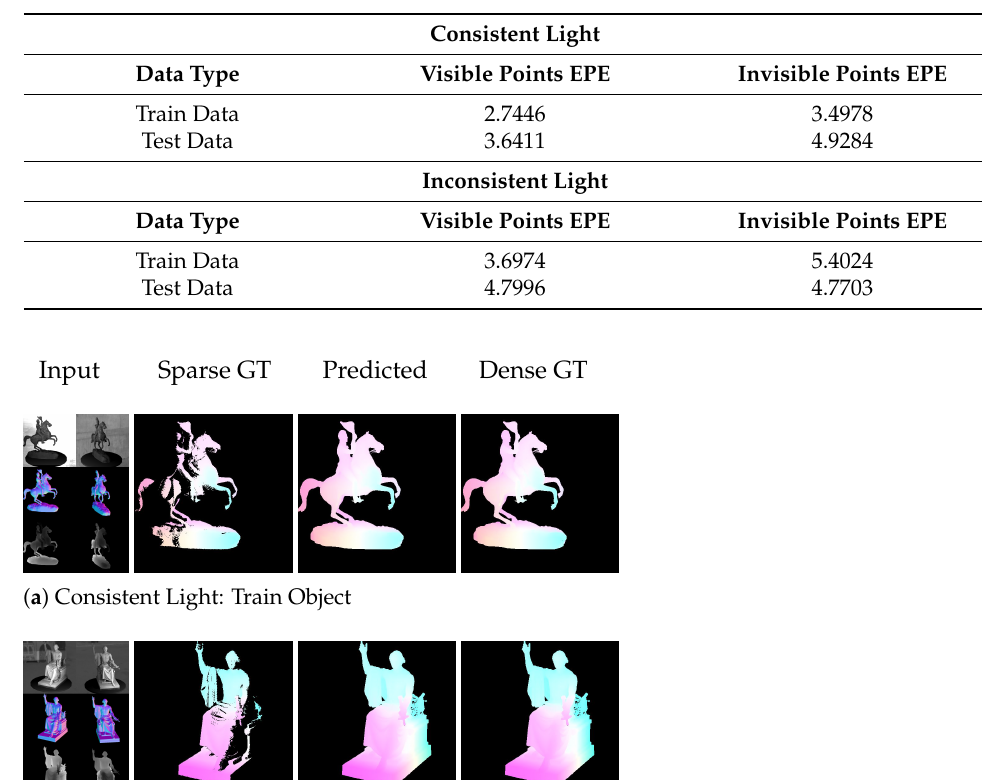
Table 3. Quantitative results for the visible and invisible points in the evaluated scenes. The resulting Endpoint Errors (EPE) do not heavily increase. The network is still able to predict accurate flows from the context of visible points and to generalize to the test data as well as for the consistent and inconsistent data.